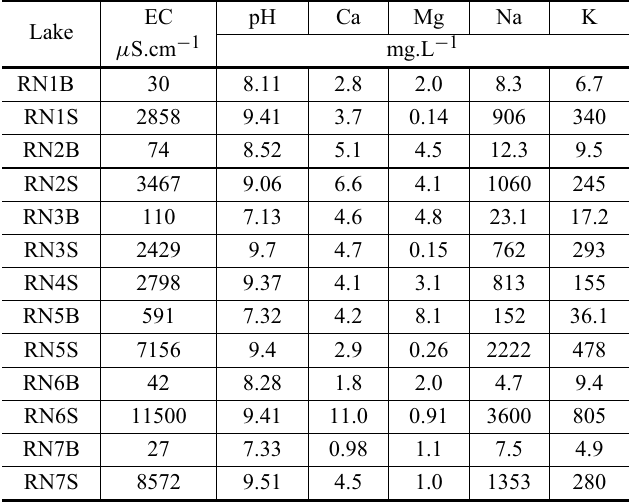
EC, pH and content in mg.L − 1 of Ca 2 + , Mg 2 + , Na + and K + of samples from the Rio Negro farm lakes (August